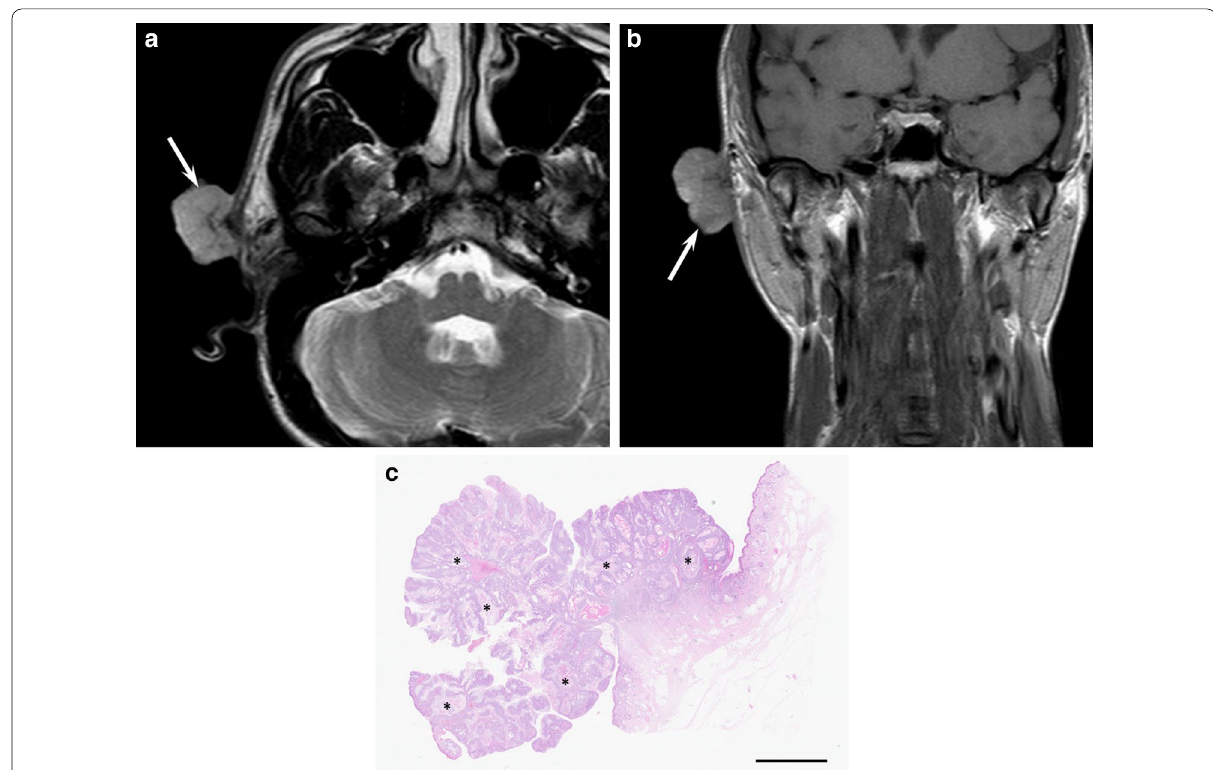
Fig. 9 A 38‑year‑old female with sebaceous carcinoma on the cheek. a Axial T2‑weighted image showing a pedunculated mass with hyperintensity (arrow). b Coronal T1‑weighted image showing a hyperintense mass relative to the muscle (arrow). c Histological specimen (H&E stain; scale bar, 5 mm) showing a pedunculated mass with interventional sebocytes